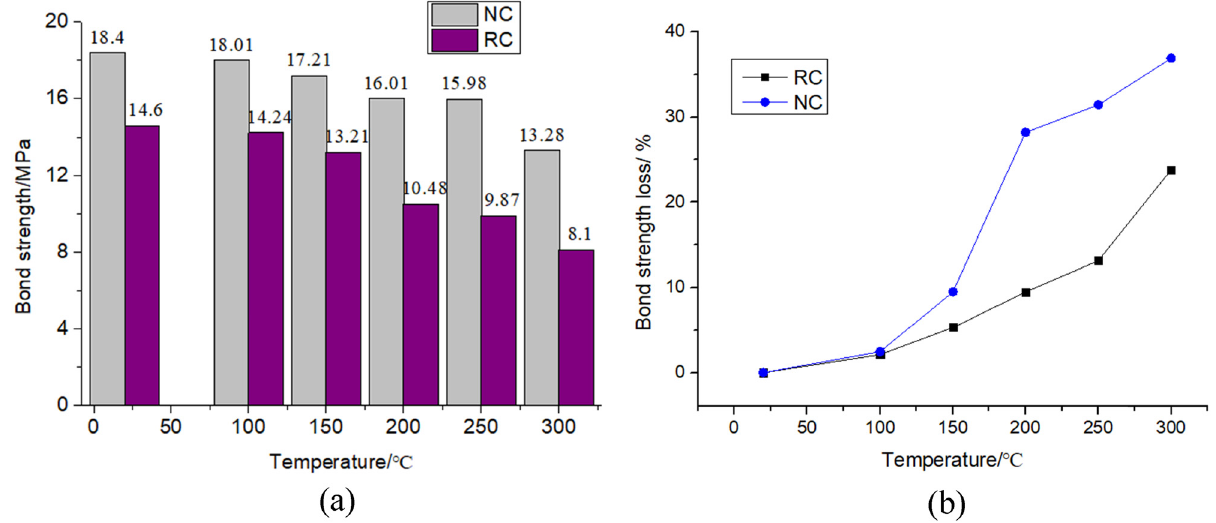
Figure 5: Bond strength after high temperature: ( a ) bond strength, ( b ) bond strength